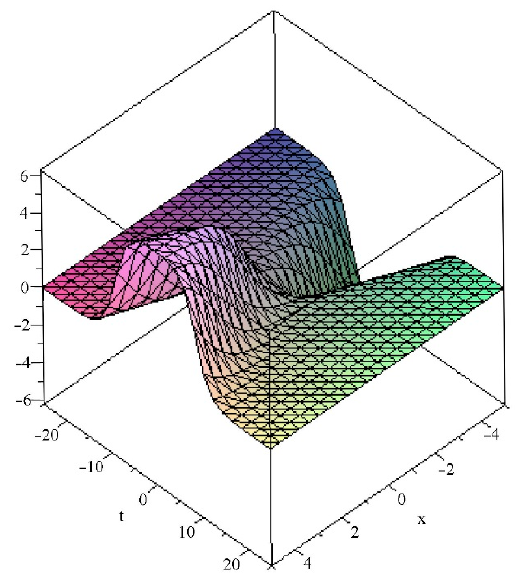
Figure 13. Geoblock displacement in the case of elastic deformation.